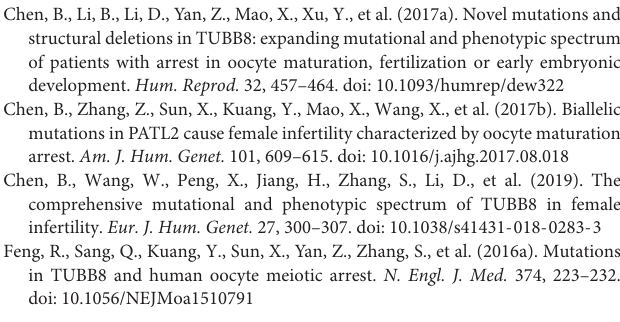
Supplementary Figure 1 | TA cloning and sequencing of patient II-1 in family 3. Sanger sequencing confirmation of a healthy individual and patient II-1 in family 3 indicates that the compound heterozygous mutation was located on two alleles, which confirms the recessive inheritance pattern. The two mutant bases are marked in red and framed in a red box. Supplementary Figure 2 | Effects of mutations on CDC20 protein level in the rescue experiment in mouse oocyte. (A) The effects of the mutations on CDC20 protein level by western blotting in mouse oocytes co-injected with cdc20 siRNA and wild-type or mutant cRNA. (B) Quantification of wild-type and mutant CDC20 corresponding of Supplementary Figure 1A . Quantification was performed by measuring the band intensity of CDC20 relative to that of vinculin. The experiment was performed with two independent biological replicates yielding similar results. The data are shown as means and SEM. * p < 0.05, ** p < 0.01. Supplementary Figure 3 | Effects of the individual mutants on CDC20 rescue ability in Cdc20 knockdown mouse oocytes. The number of oocytes with PB1 extrusion and the total number of oocytes used are listed at the top of the column. Significance was compared between the no injection group and the si Cdc20 group, the si Cdc20 coupled with wild-type CDC20 cRNA group, and the si Cdc20 coupled with mutant CDC20 cRNA groups. Experiments were performed followed the chi-square test. * p < 0.05, *** p < 0.001, **** p < 0.0001, ns, not